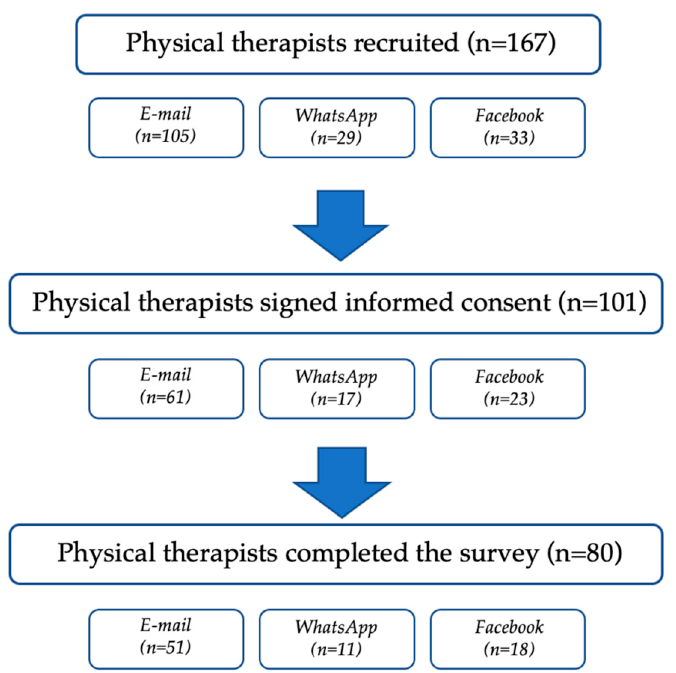
Figure 1. Survey response flow chart.